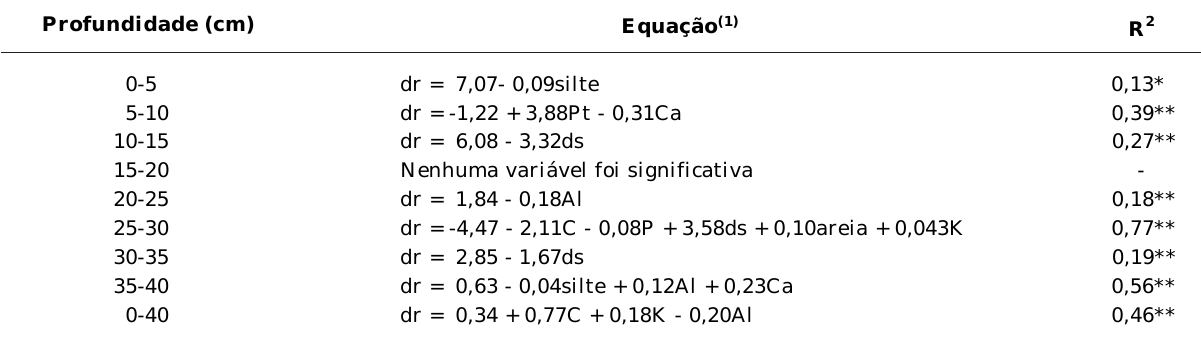
Quadro 2. Regressões linear simples e múltipla para densidade de raízes (dr) em diferentes profundidades no perfil do solo